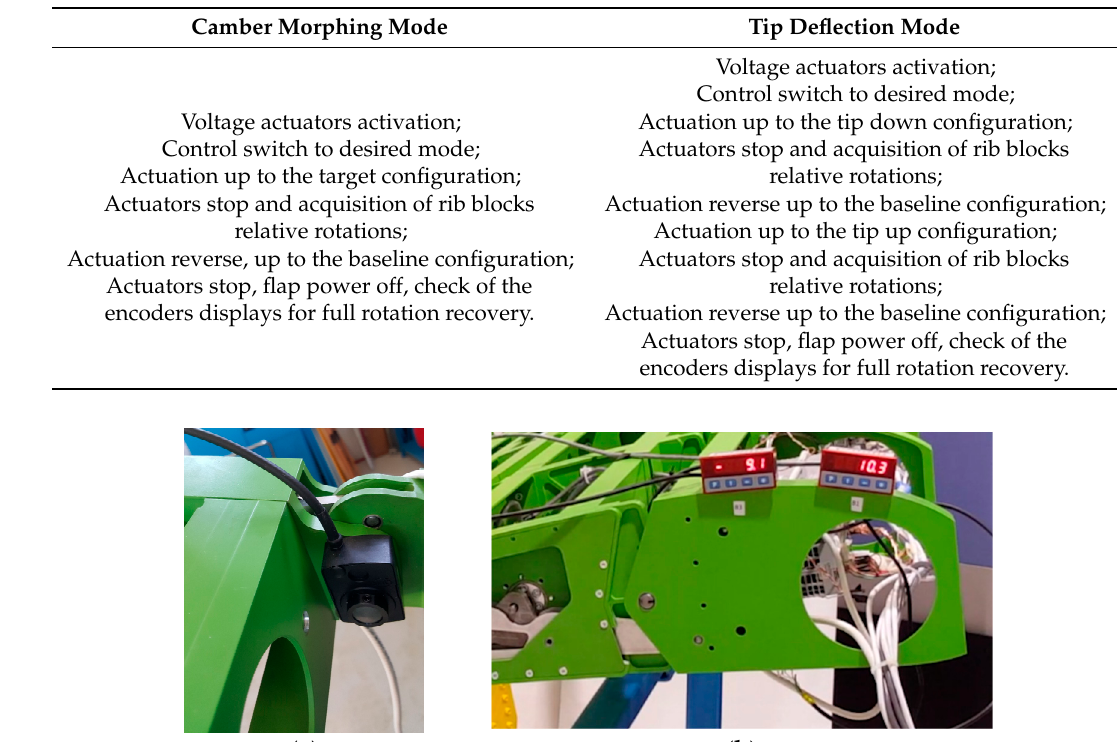
Table 4. Functionality test protocol.